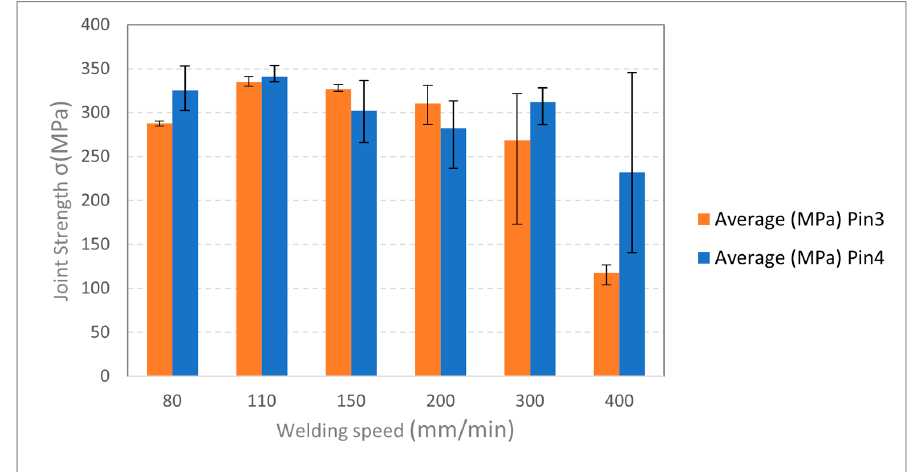
Figure 5. Tensile strength of joints prepared at rotation speed 1000 rpm for various welding speeds (Pin3 is 3 mm diameter pin tool, Pin4 is 4 mm diameter pin tool).